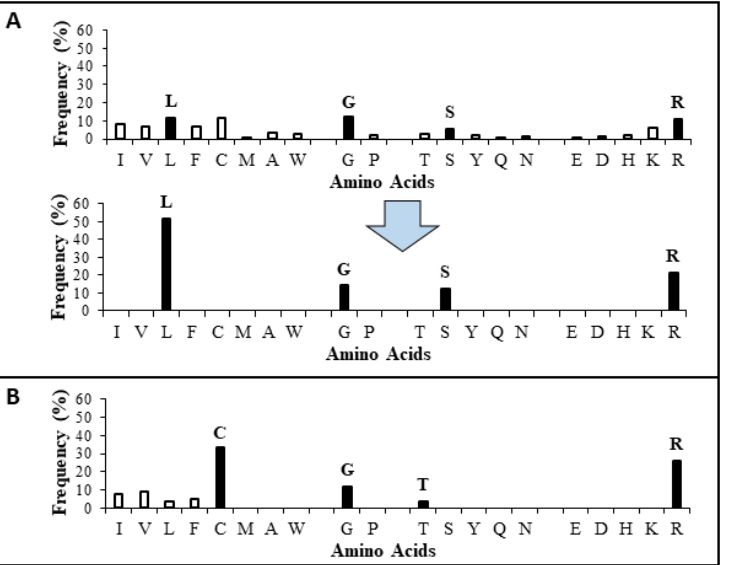
Figure 2. A single-step amino acid analysis of antiviral peptides with 11–20 amino acids to derive multiple most probable parameters for peptide design. ( A ) Four frequent amino acids (L, G, S, and R, solid column) were identified from the four groups of amino acids. The percentages of amino acids for each group were then merged into L, G, S, and R. ( B ) The amino acid analysis of 19 ɵ -defensins registered in the APD. It is remarkable that in nature, ɵ -defensins are designed in a similar way by mainly using C, G, T, and R dotted with a few other hydrophobic amino acids.